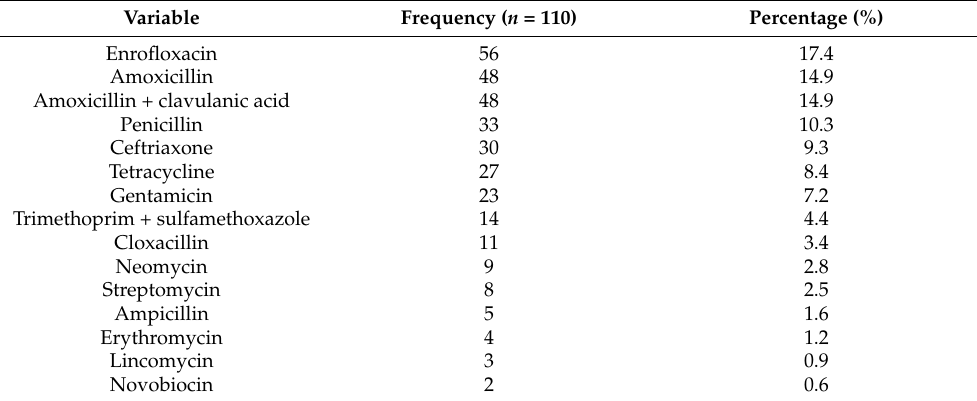
Table 12. The most frequently used antibiotics in cow mastitis therapy.